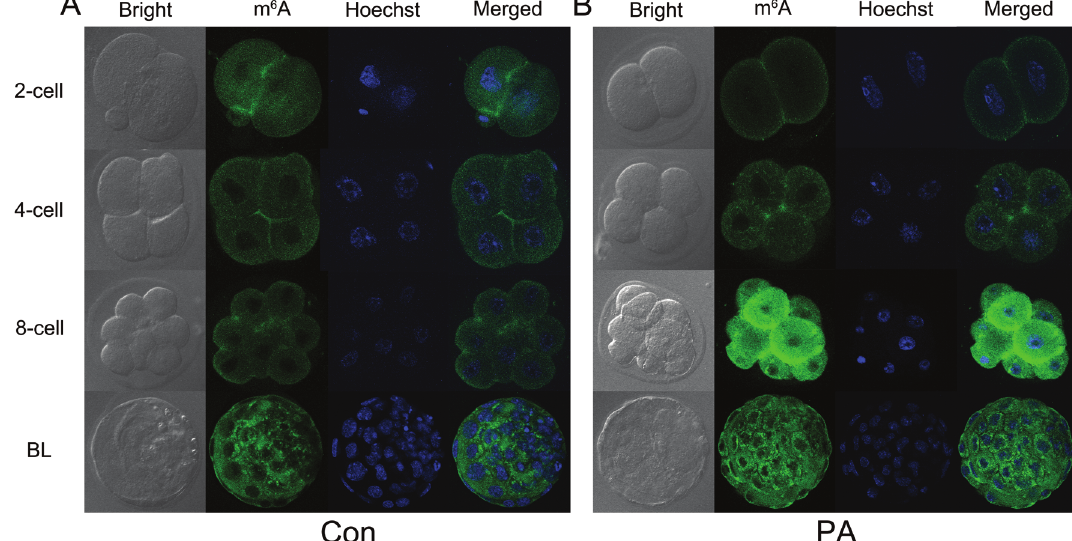
Figure 3 - Immunofluorescence localization of m6A. The expression patterns of m6A in 2-cell, 4-cell, 8-cell, and blastocyst stages of normal (A) and PA (B) embryos. BL indicates the blastocyst stage of the embryo. Green indicates m6A. Blue indicates DNA stain.